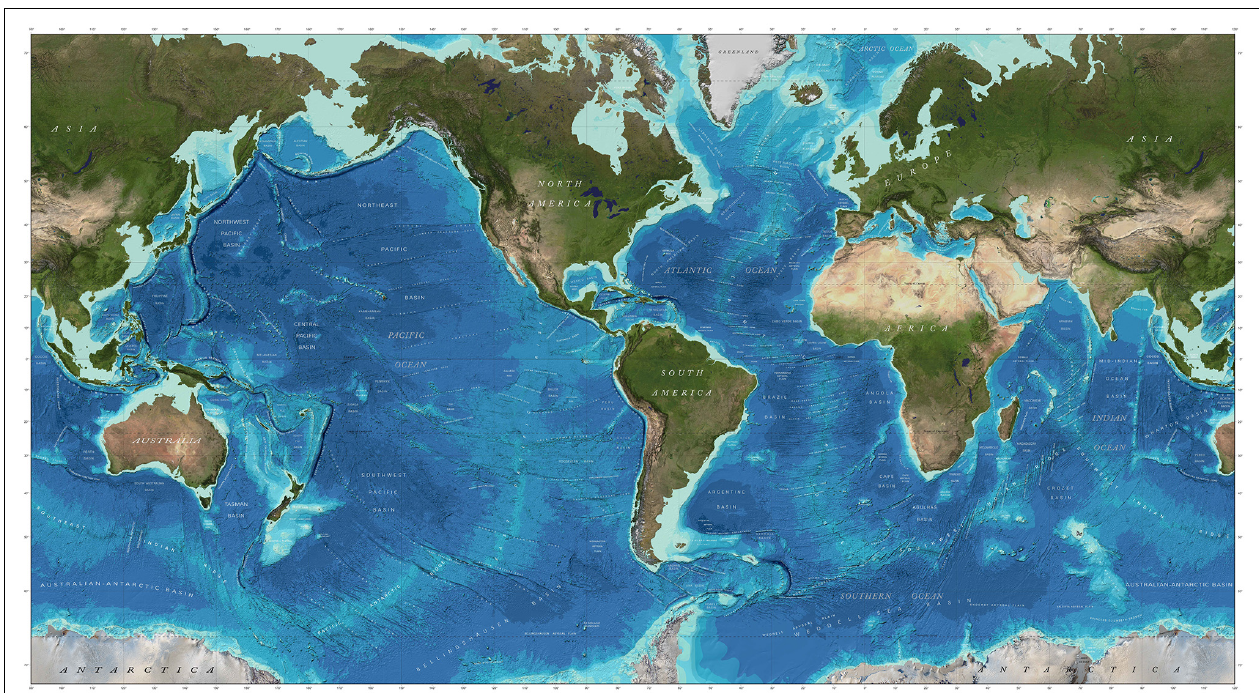
FIGURE 4 | World map of currently available hi-resolution bathymetric data. Image reproduced from the GEBCO world map 2014,